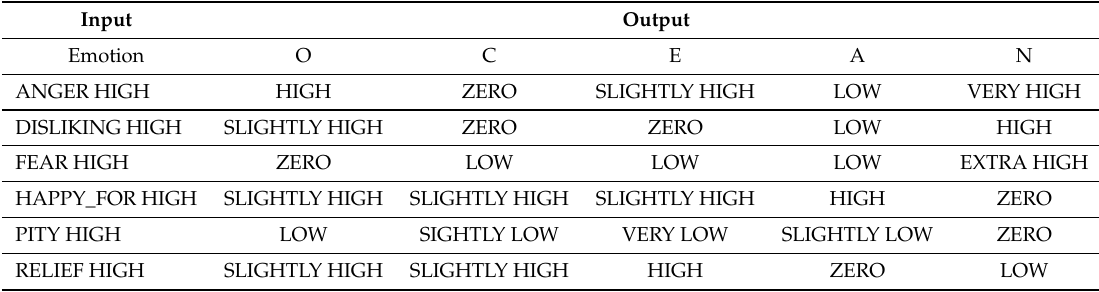
Table 3. Relation between emotions (input) and OCEAN’s values